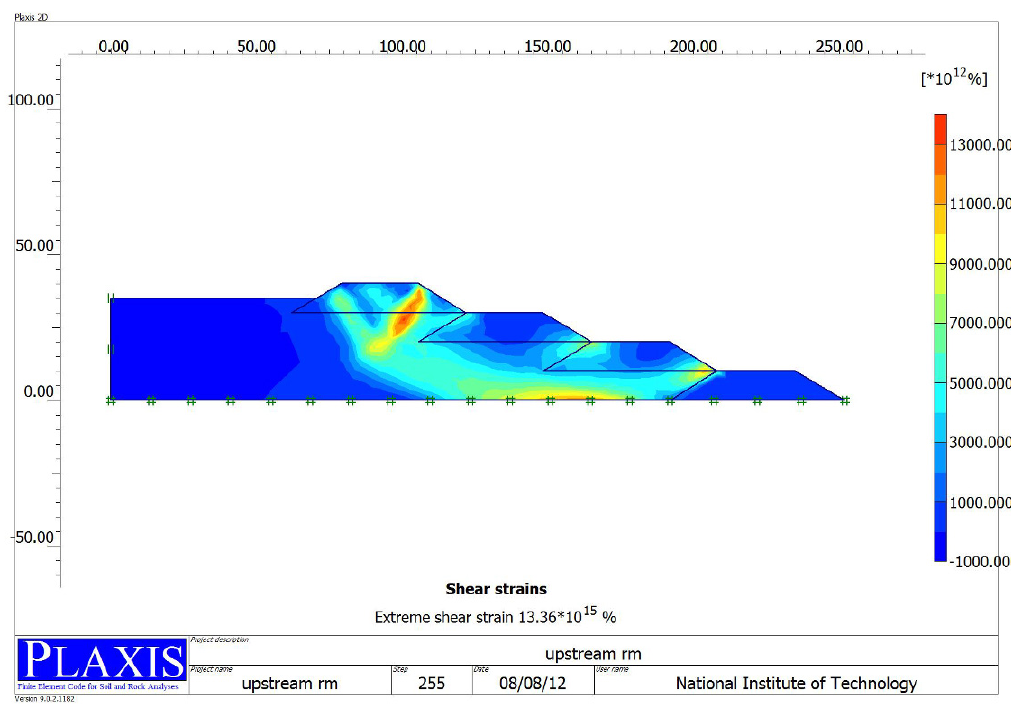
Figure 9. Strain diagram dam in upstream method case showing the failure surface